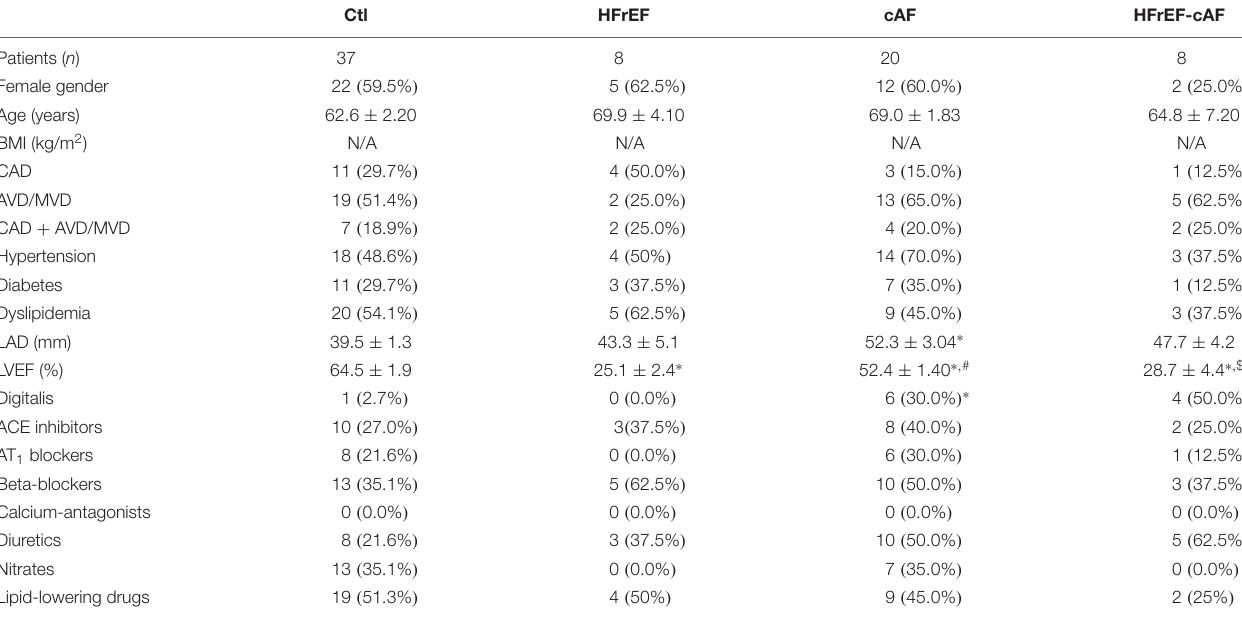
TABLE 2 | Clinical characteristics of patient samples used for voltage-clamp recordings in isolated atrial cardiomyocytes. Ctl HFrEF